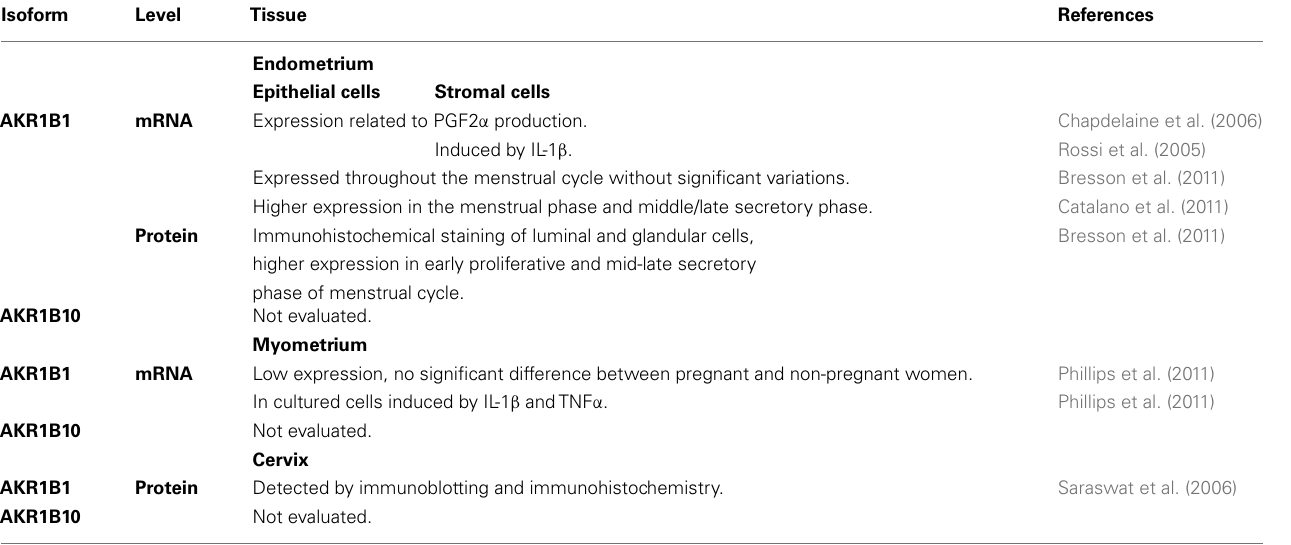
Table 2 | Expression of AKR1B1 and AKR1B10 in human uterus.